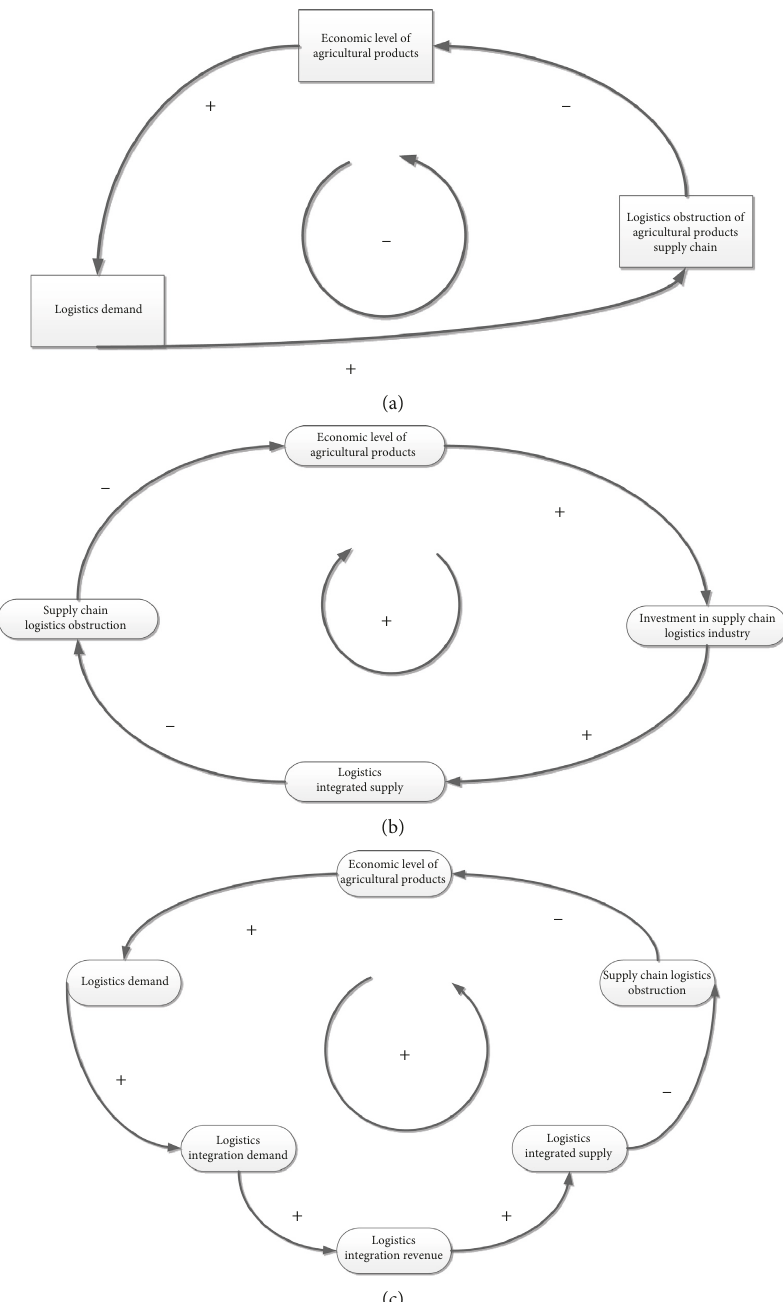
Figure 6: Total causal relationship subsystem of agricultural product supply chain system. (a) External Economic Environment Subsystem. (b) Logistics Integrated Demand Subsystem. (c) Logistics Integrated Supply